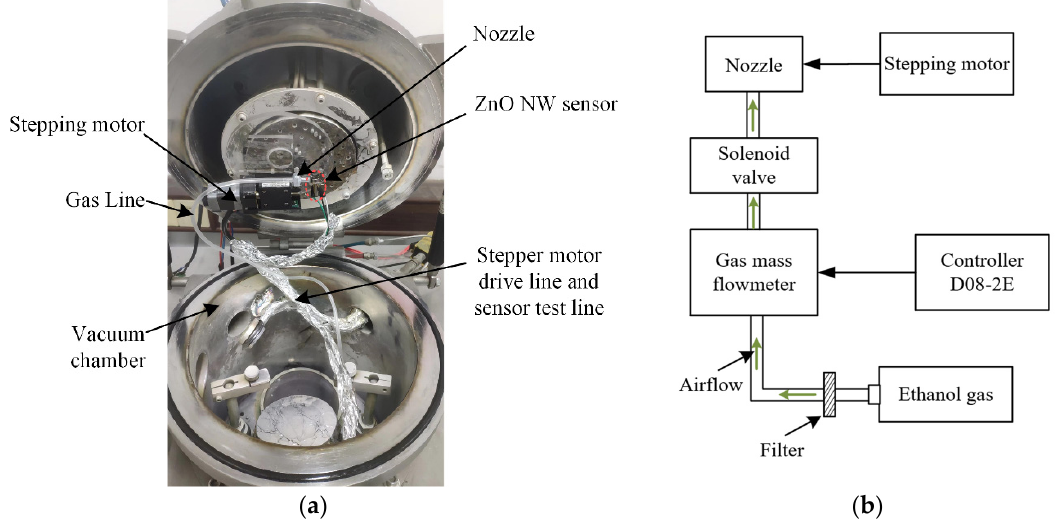
Figure 6. Diagram of the detection device: ( a ) Arrangement of test devices in vacuum cavities; ( b ) schematic diagram of the controlled flow of ethanol gas.